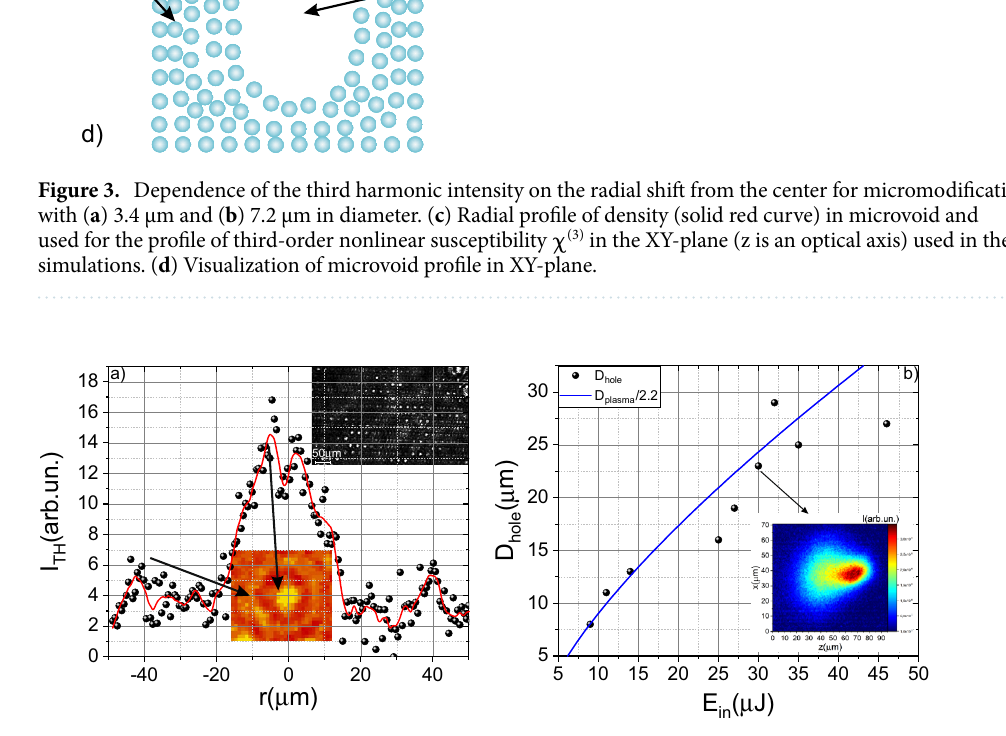
Figure 4. ( a ) Micromodification profile obtained by third harmonic imaging. The energy of the laser pulse is 1.1 μJ. The insets show single micromodification as well as an array of created micromodifications. ( b ) Dependence of the micromodification diameter on the laser pulse energy. The blue line shows the dependence of the plasma diameter in the air (divided by a factor of 2.2) on the laser pulse energy. The inset demonstrates the plasma luminescence